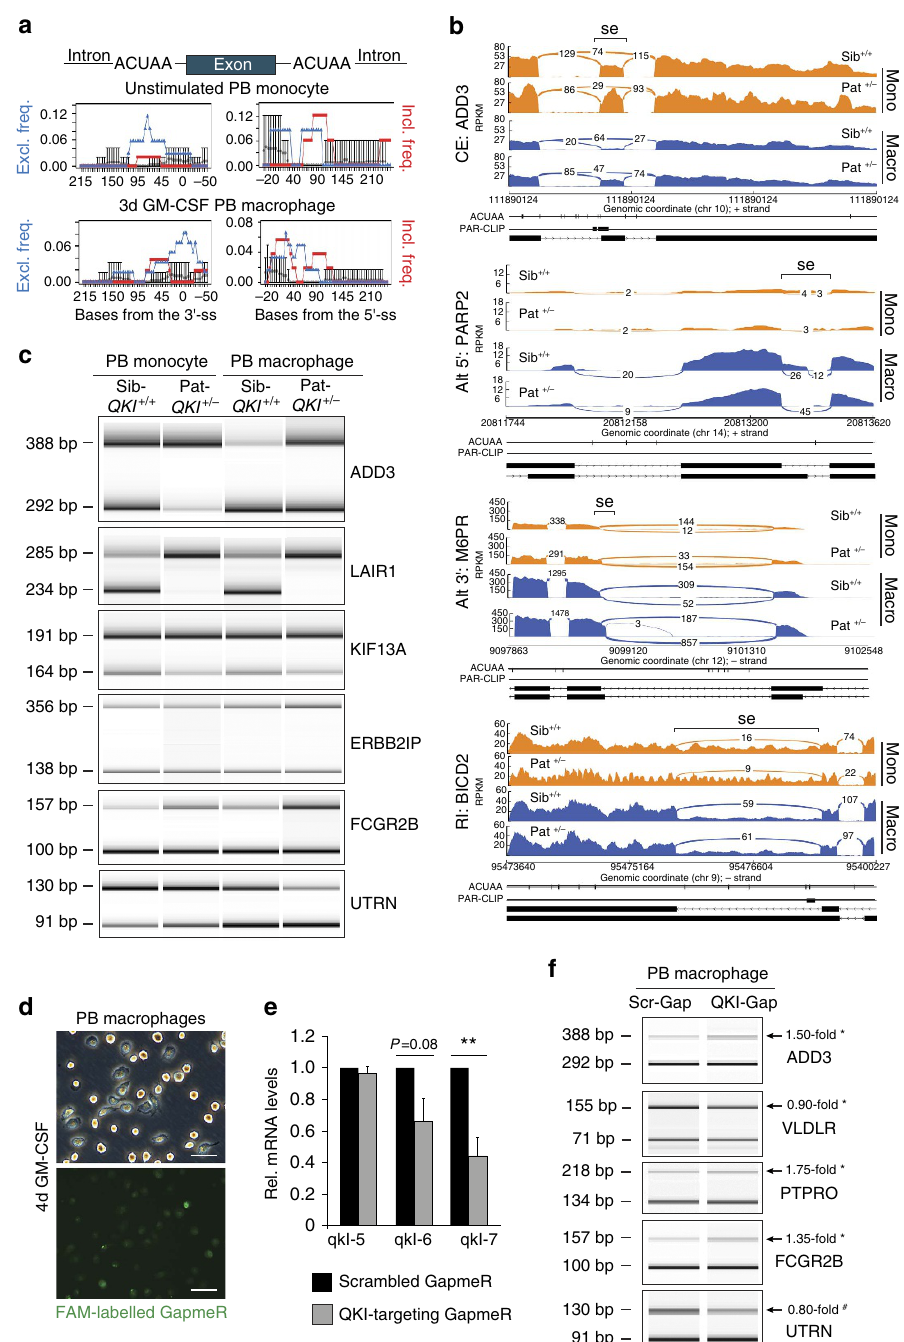
Figure 4 | QKI influences pre-mRNA splicing in naive PB monocytes and macrophages. ( a ) SpliceTrap assessment of the proximal ACUAA RNA motif enrichment in 50-bp windows upstream and downstream of alternatively spliced cassette exons (as compared with a background set of exons; grey circles). The relationship between the frequency of exon exclusion (blue triangles) or exon inclusion (red squares) and ACUAA RNA motif enrichment over the genomic locus are depicted. ( b ) Sashimi plots illustrate RNA-seq read coverage for selected alternative splicing events in Pat- QKI þ / (cid:2) versus Sib- QKI þ / þ PB monocytes (orange) and macrophages (blue). Splicing events (se) are highlighted by inverted brackets. The location of ACUAA motifs and QKI PAR-CLIPs are provided below. Splicing events were defined based on the genomic organization of RefSeq transcripts (bottom tracks). Full event details are provided in Supplementary Data 3. ( c ) PCR validation of alternatively spliced cassette exons in Sib- QKI þ / þ and Pat- QKI þ / (cid:2) PB-derived monocytes and macrophages. Primers were designed to target constitutive flanking exons. PCR product size for exon inclusion (top) and exclusion (bottom) variants are provided (left). ( d ) Phase-contrast and fluorescence-microscopy photographs (scale bar, 50 m m) of primary human, PB macrophages of healthy controls that have been treated with FAM-labelled GapmeRs, to reduce QKI expression. ( e ) Quantitative RT–PCR (qRT–PCR) of QKI mRNA isoform expression in GapmeR-treated macrophages ( n ¼ 3). Data expressed as mean ± s.e.m.; Student’s t -test, with ** P o 0.01. ( f ) PCR validation of alternatively spliced cassette exons in GapmeR-treated PB-derived macrophages. Primers were designed to target constitutive flanking exons. PCR product size for exon inclusion (top) and exclusion (bottom) variants are provided (left). A representative illustration is shown of an n ¼ 3 donors. Data expressed as mean ± s.e.m.; Student’s t -test, with ** P o 0.01 and # P ¼ 0.08. NATURE COMMUNICATIONS|7:10846|DOI: